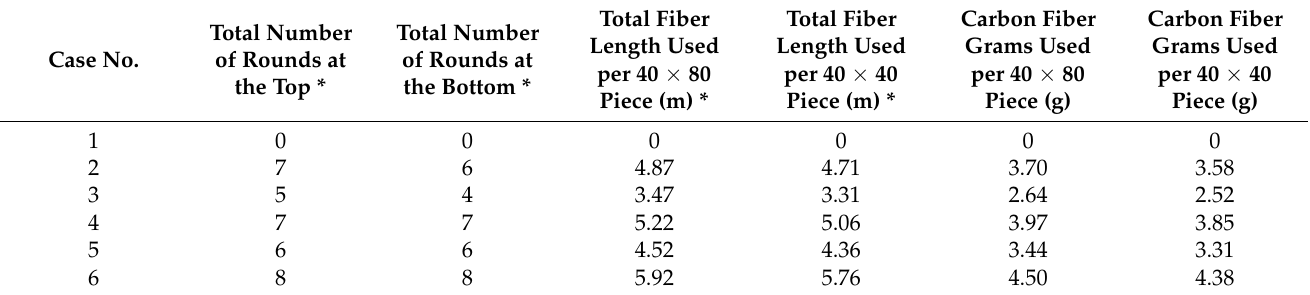
Table 1. Summary of the number of carbon fibers used to reinforce each